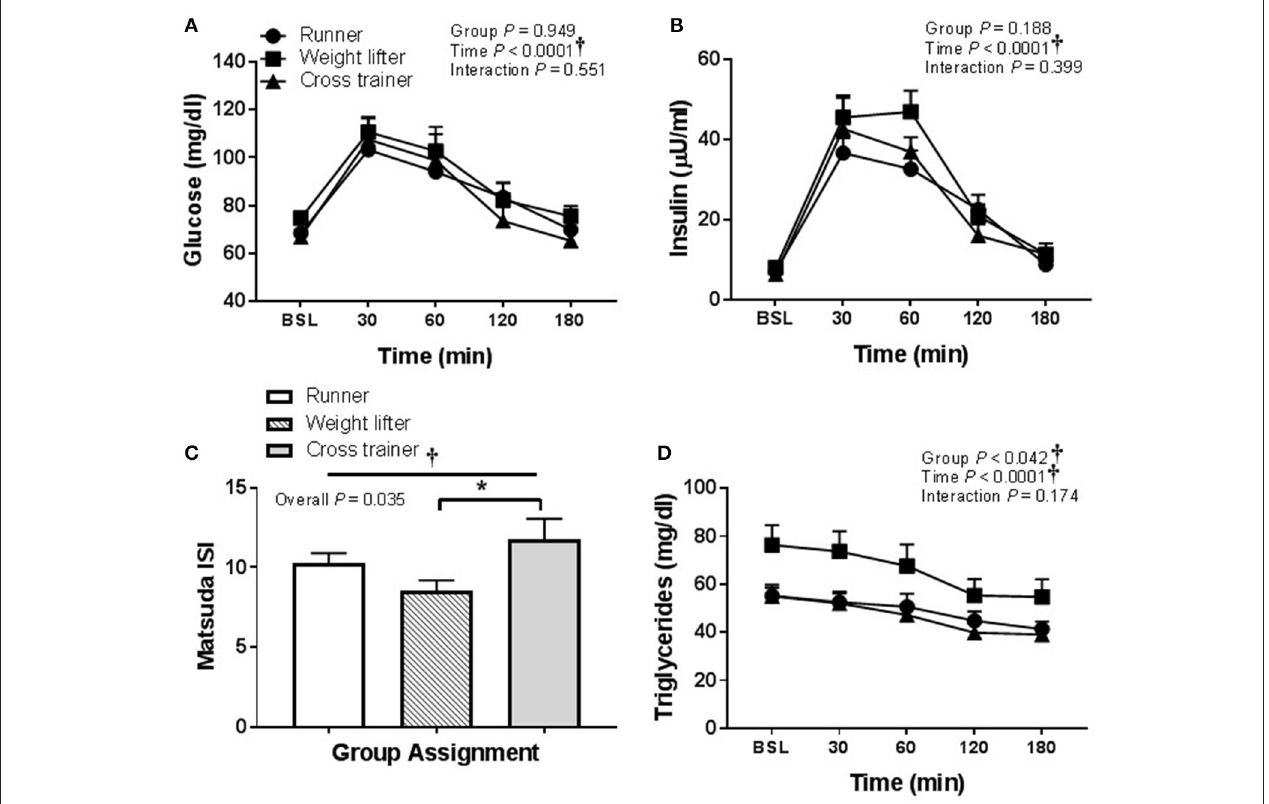
FIGURE 9 | Metabolic responses at baseline, and 30, 60, 90, 120, and 180min to a 75g glucose high sugar meal (HSM) in runners ( n = 11), weightlifters ( n = 13), and cross-trainers ( n = 9). (A) Blood glucose response over 180min. (B) Serum insulin levels over 180min (C) Matsuda insulin sensitivity index (ISI) and (D) Serum triglyceride levels over 180min. All data presented as mean ± SEM. † Indicates significant main or interaction effect ( P < 0.05). *Indicates significant difference between groups (adjusted P < 0.05; Sidak-Bonferroni adjustment for ANOVA multiple comparisons).